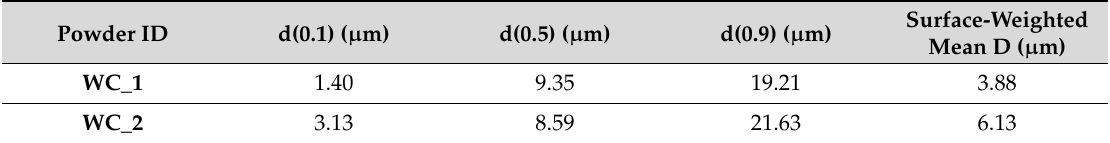
Table 2. Grain size distribution of WC_1 and WC_2 powders.